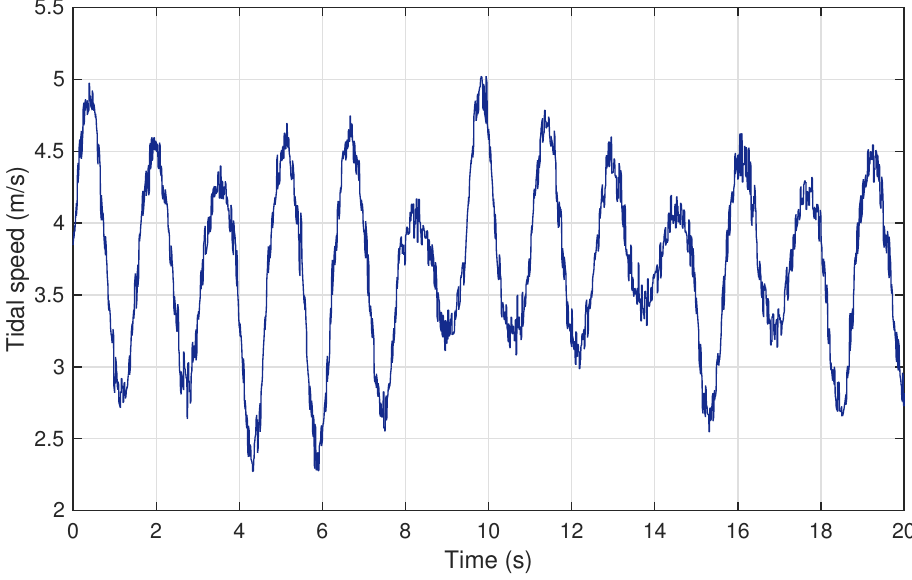
Figure 20. Case 2: Irregular disturbed tidal speed input.